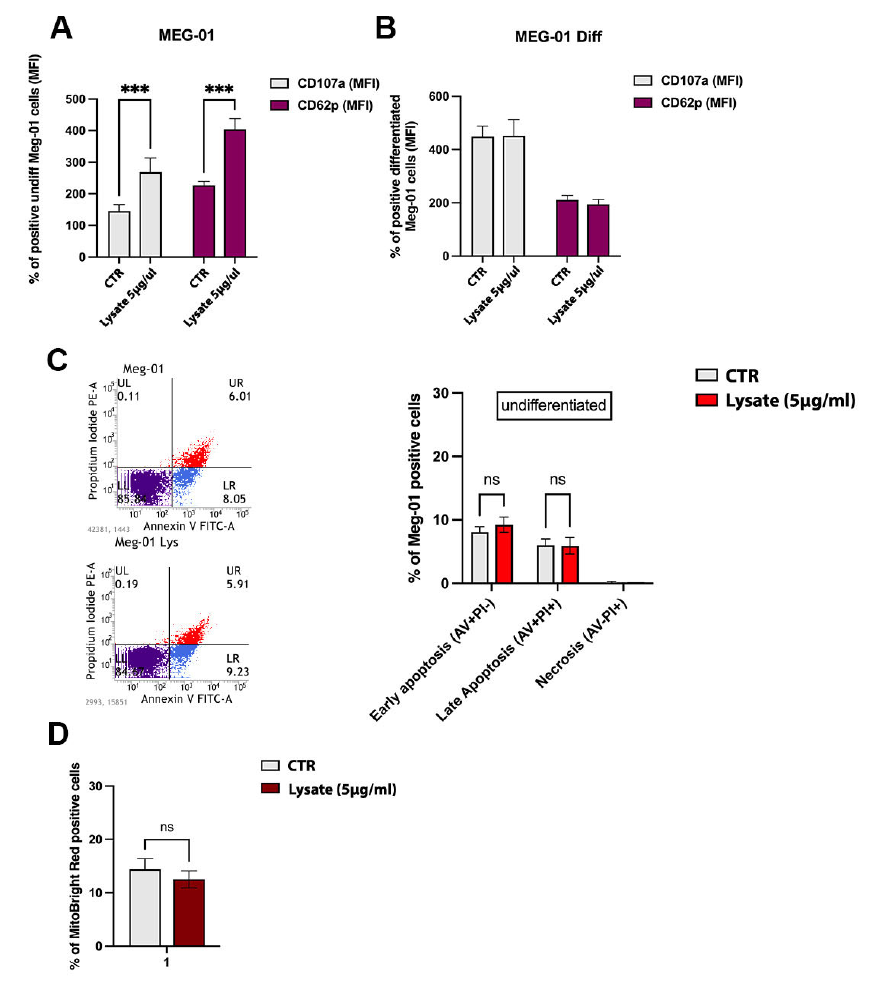
Figure 2. Functional characterization of platelet-like particles released by MEG-01 cells. ( A , B ) SARS- CoV-2 lysate’s effect on platelet-like particle activation. The bar graphs show the percentage of CD107a+ (gray bars) and CD62p+ (purple bars)-positive undifferentiated and differentiated MEG-01 cells exposed to inactivated SARS-CoV-2 lysate (5 µ g/mL) or control lysate for 3 h. The cytofluorimetric mean fluorescence intensity (MFI) is indicated. The result is representative of three independent experiments expressed as mean ± SD. Pairwise comparison is reported (ordinary one-way ANOVA; *** p < 0.001; in ( B ), no significant p -values were found, reported as ns). ( C ) SARS-CoV-2 lysate induction of apoptosis measured by Annexin V and propidium iodide (PI) double-staining through flow cytometry in the undifferentiated MEG-01 cell line after 24 h of treatment with inactivated SARS- CoV-2 lysate (5 µ g/mL). Histograms on the right indicate the total percentage of early (Annexin V-positive cells/PI-negative cells) and late apoptotic events (Annexin V/PI-double-positive cells) as well as necrotic cells (Annexin V-negative cells/PI-positive cells). The results are representative of three independent experiments expressed as mean ± SD. Statistical analysis by two-way ANOVA with Tukey’s test for multiple comparisons was conducted (no significant p -values were found). ( D ) SARS-CoV-2’s impact on mitochondrial activity was measured by MitoBright Red staining by flow cytometry in the undifferentiated MEG-01 cell line after 24 h of treatment with inactivated SARS-CoV-2 lysate (5 µ g/mL). The bar graph shows the percentage of MitoBright Red-positive parental MEG-01 cells as a result of three independent experiments expressed as mean ± SD. All the results were compared to the effects of cells exposed to control lysate CTR (5 µ g/mL) obtained from non-infected MEG-01 in the same conditions. A pairwise comparison is reported (ordinary one-way ANOVA; no significant p -value was